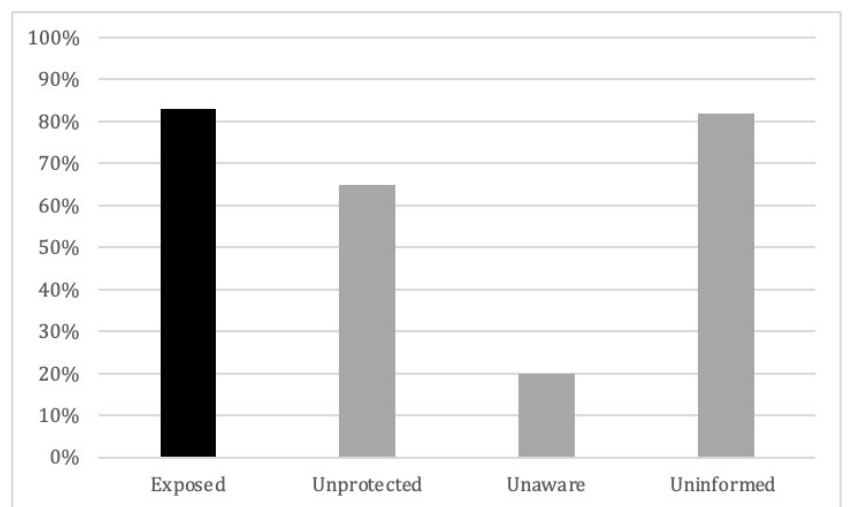
Figure 2. Percent self-reporting noise exposure at work (Exposed) and hearing protection usage (Unprotected), awareness of existing workplace hearing protection policies (Unaware), and knowledge of NIHL (Uninformed.)